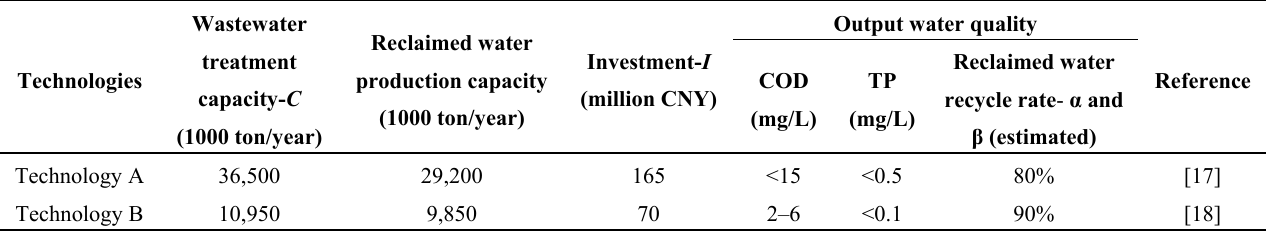
Table 1. Comparison between Technology A and B.